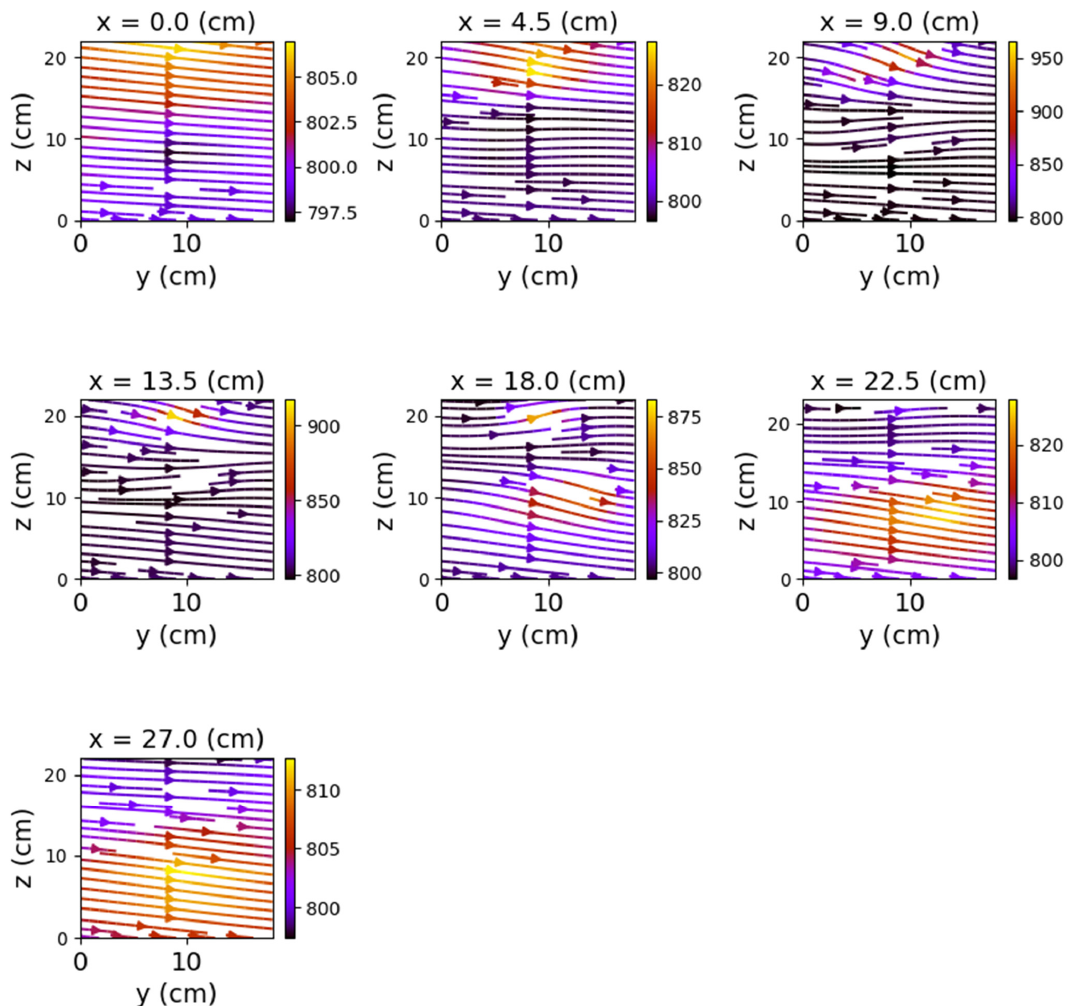
Figure 15. Field lines for y O z plane—relay with coil 1-3 powered.